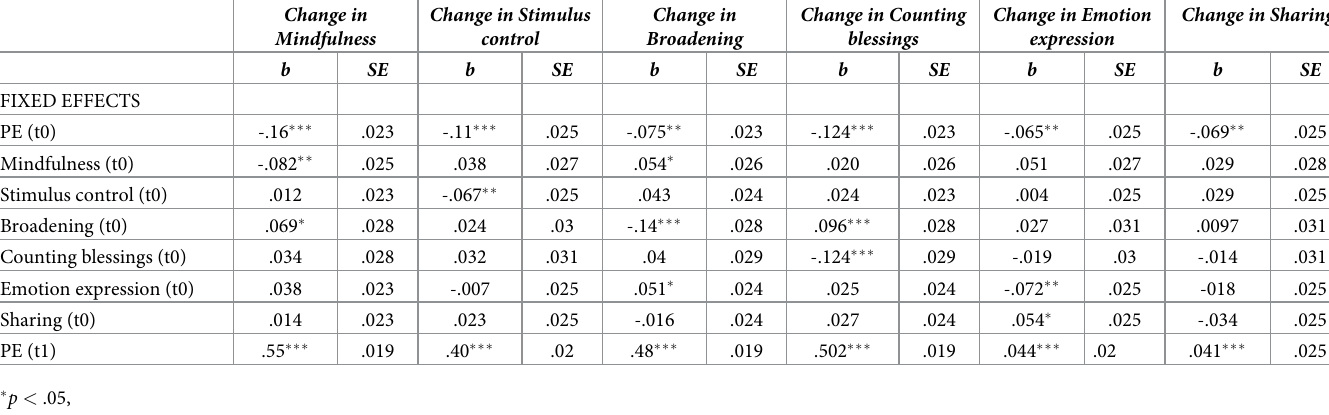
Table 2. Results of the six linear mixed-effects models predicting change in strategy use from PE at t0.